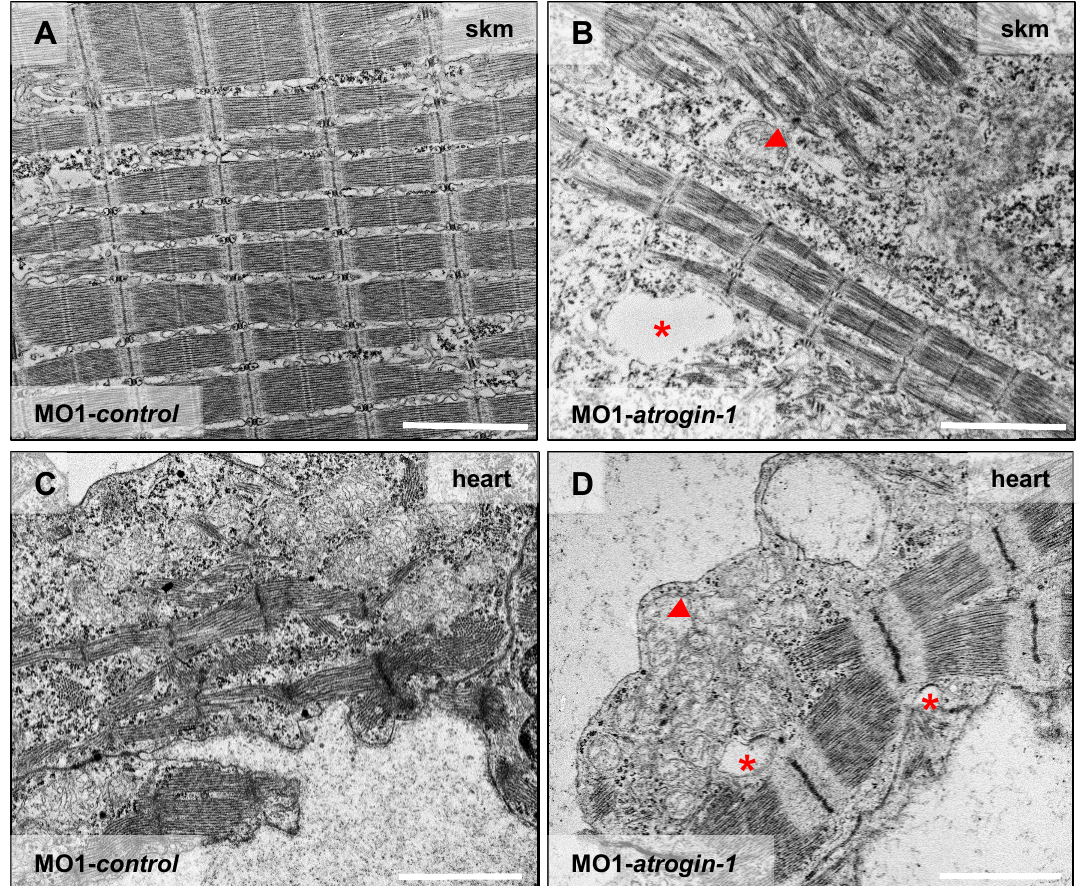
Figure 6. Atrogin-1 deficiency leads to an autophagy-related ultrastructural muscle pathology. ( A – D ) Electron micrographs of cardiomyocytes (heart) and skeletal muscle cells (skm) of Atrogin-1 morphants and embryos injected with control Morpholino at 72 hpf. Asterisks indicate vesicular bodies, arrowhead indicates dysmorphic mitochondria, scale bar = 2 µm.